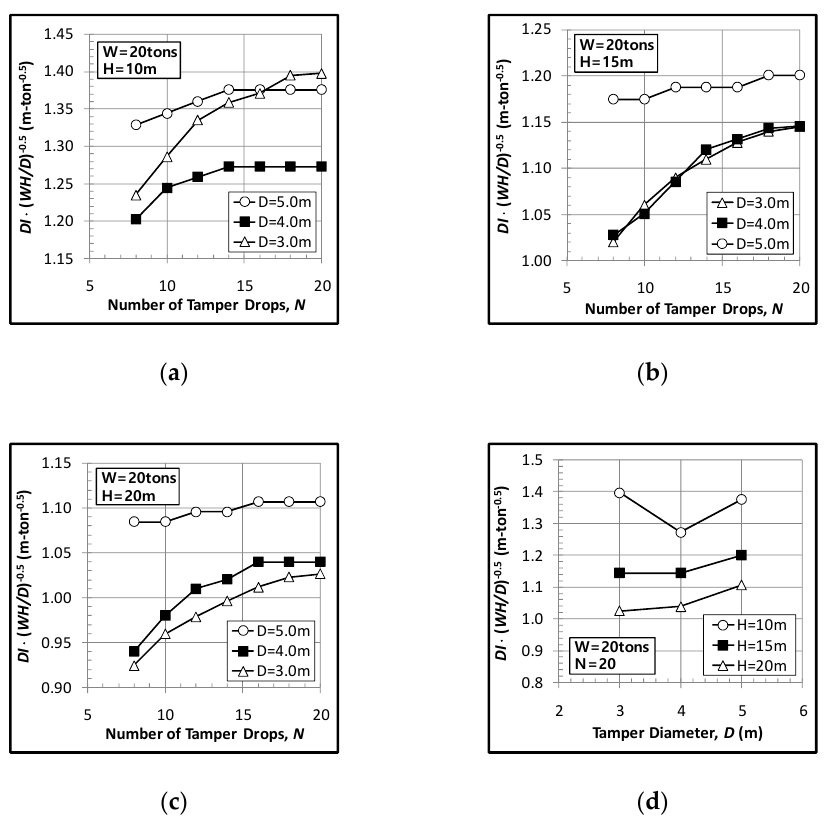
Figure 12. Relationship between improvement depth and compaction energy with increase in number of drops: ( a ) H = 10 m; ( b ) H = 15 m; ( c ) H = 20 m; ( d ) N = 20.